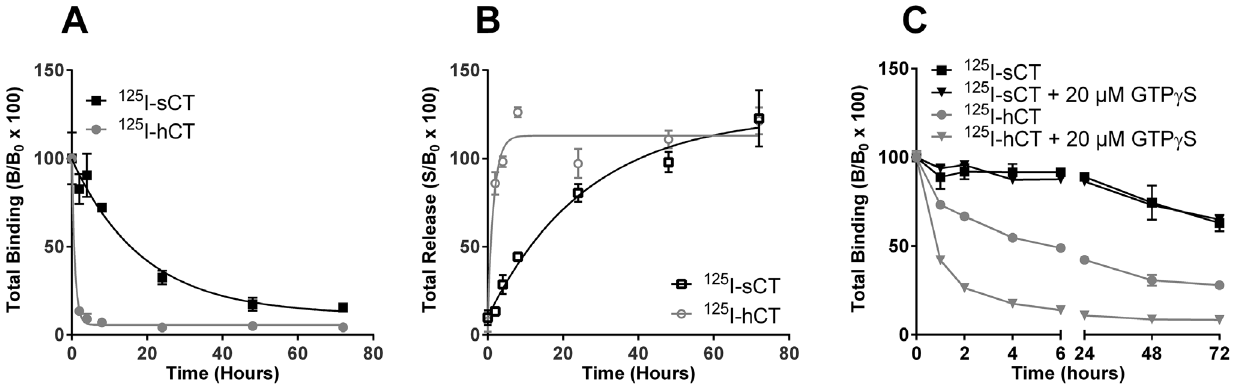
Figure 7. Prolonged ligand dissociation kinetics on membranes preparations and live cells. A) Total binding of 125 I-sCT and 125 I-hCT ligand bound to U2OS CALCR cells at different time points (0, 2, 4, 8, 24, 48 and 72 hours). B 0 is total 125 I-ligand bound to cells at t=0 and B is 125 I- ligand bound. B) Specific activity of 125 I-sCT and 125 I-hCT ligand released into the supernatant by cells in (B) at different time points (0, 2, 4, 8, 24, 48 and 72 hours). C) 125 I-sCT and 125 I-hCT ligand dissociation was investigated using isolated U2OS CALCR membrane preparations. The dissociation from the membranes was measured after 1, 2, 4, 8, 24, 48 and 72 hours with or without the presence of 20 m M GTP c S to determine G-protein dependency. B 0 is total 125 I-ligand bound to membranes at t=0 and B is 125 I-ligand bound.B 0 is total 125 I-ligand bound to cells at t=0 and S is 125 I- ligand in the medium. Live cell assays were conducted at 37 u C and membrane assays were conducted at room